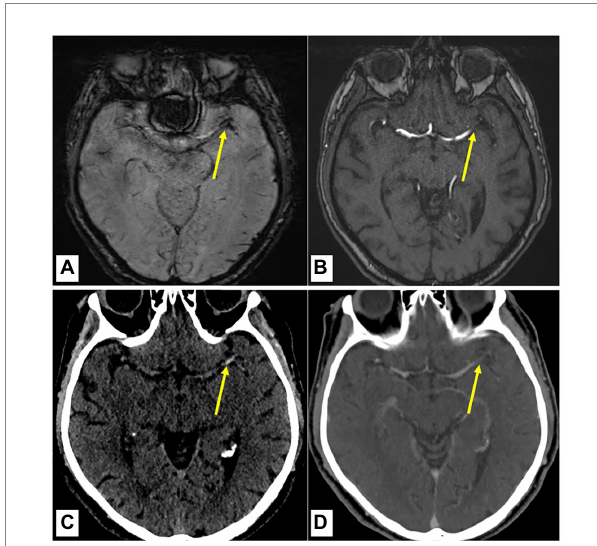
FIGURE 1 Assessment of the susceptibility vessel sign and hyperdense vessel sign status on baseline brain imaging. (A,B) 70-year-old male patient with an acute ischemic stroke due to the occlusion of the left MCA (M1 segment) diagnosed on baseline brain MRI with present SVS (arrowhead) as local hypointensity on the SWI (A) with confirmation of occlusion on the arterial TOF (B) . (C,D) Externally performed CT imaging of the same patient before referring for thrombectomy. Presence of HVS (arrowhead) as local hyperdensity in native CT (C) with confirmation of occlusion in the CT angiography (D) . Yellow arrows point to the proximal part of the vessel occlusion. HVS indicates hyperdense vessel sign; MCA, middle cerebral artery; SVS, susceptibility vessel sign; SWI, susceptibility weighted imaging and TOF, time of flight